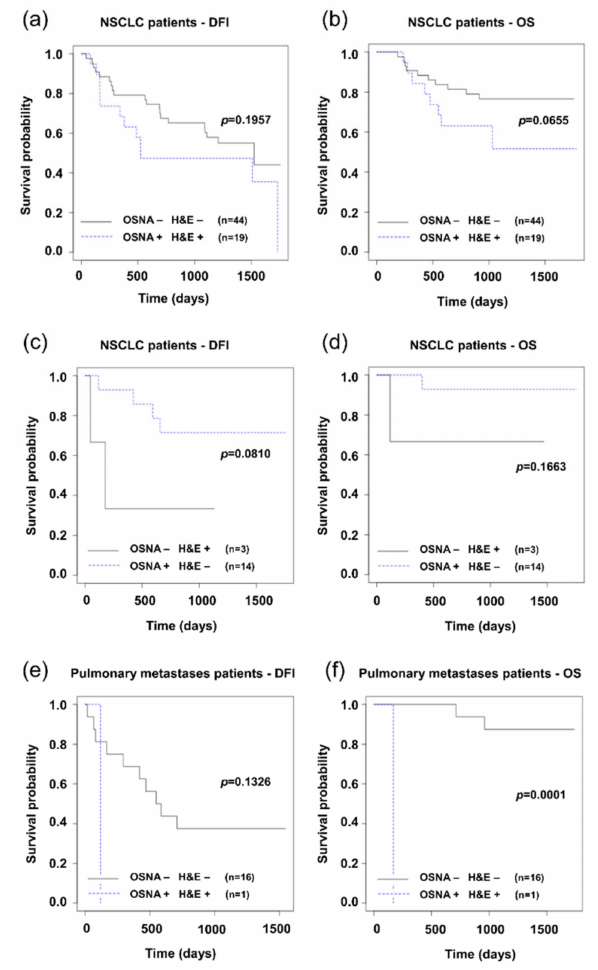
Figure 2. Kaplan-Meier survival distribution functions of patients stratified according to lymph node status (result of method negative: − , result of method positive: + ). ( a ) Disease-free survival (DFI) of non-small cell lung carcinoma (NSCLC) patients with concordance of H&E and OSNA (OSNA − H&E − vs. OSNA + H&E + ); ( b ) overall survival (OS) of NSCLC patients with concordance of H&E and OSNA; ( c ) disease-free survival (DFI) of NSCLC patients with discordance of H&E and OSNA (OSNA − H&E + vs. OSNA + H&E − ); ( d ) overall survival (OS) of NSCLC patients with discordance of H&E and OSNA; ( e ) disease-free survival (DFI) of pulmonary metastases patients with concordance of H&E and OSNA; ( f ) overall survival (OS) of pulmonary metastases patients with concordance of H&E and